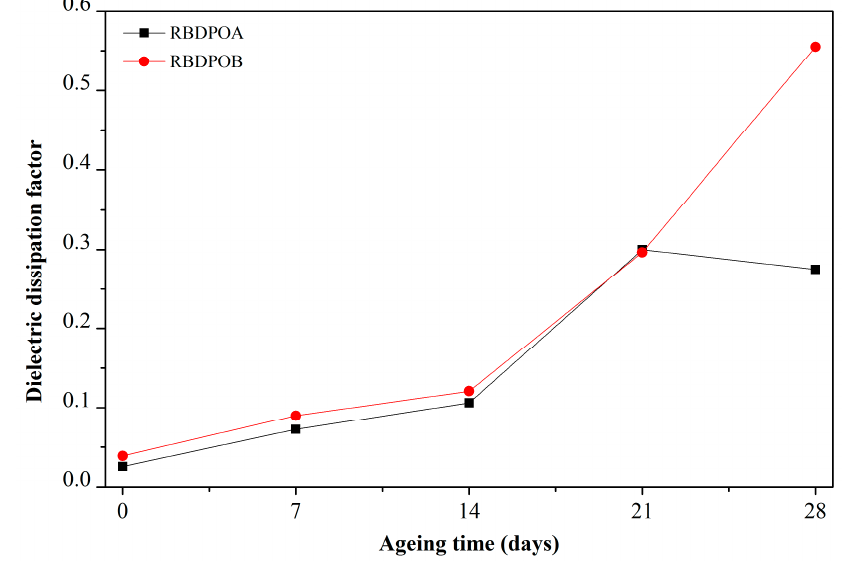
Figure 6. Dielectric dissipation factor of RBDPO aged at 170 °C under open conditions.